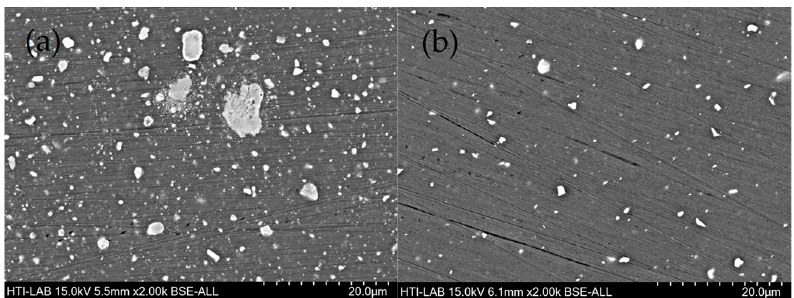
Figure 11. SEM Images of (2000×) ( a ) FSPed recycled AA 6063/TiO 2 and ( b ) FSPed recycled AA 6063 produced at 2442 rpm and 50 mm/min.